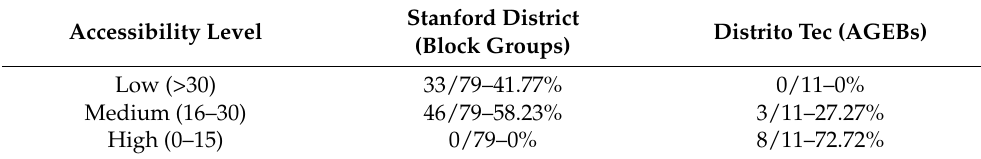
Figure 12. Stanford District average travel time to the 3 closest public elementary schools by foot. Table 9. Accessibility level to elementary schools traveling by foot per aggregation